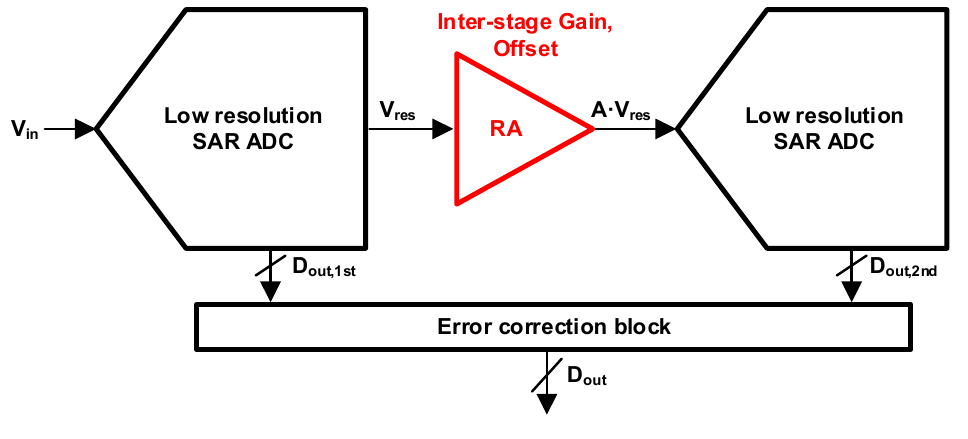
Figure 1. Block diagram of the Pipelined-SAR ADC.